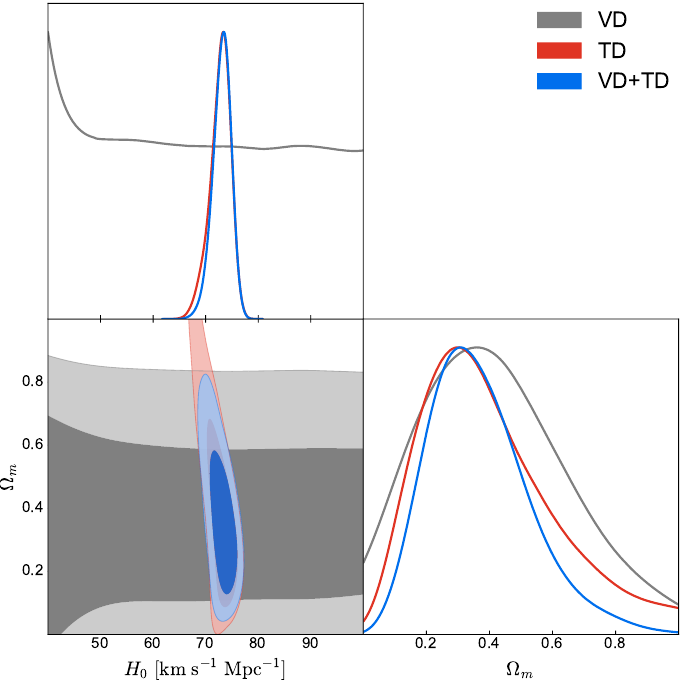
Figure 1. The constraints (68.3% and 95.4% confidence level) on the Λ CDM model from VD, TD, and VD+TD.